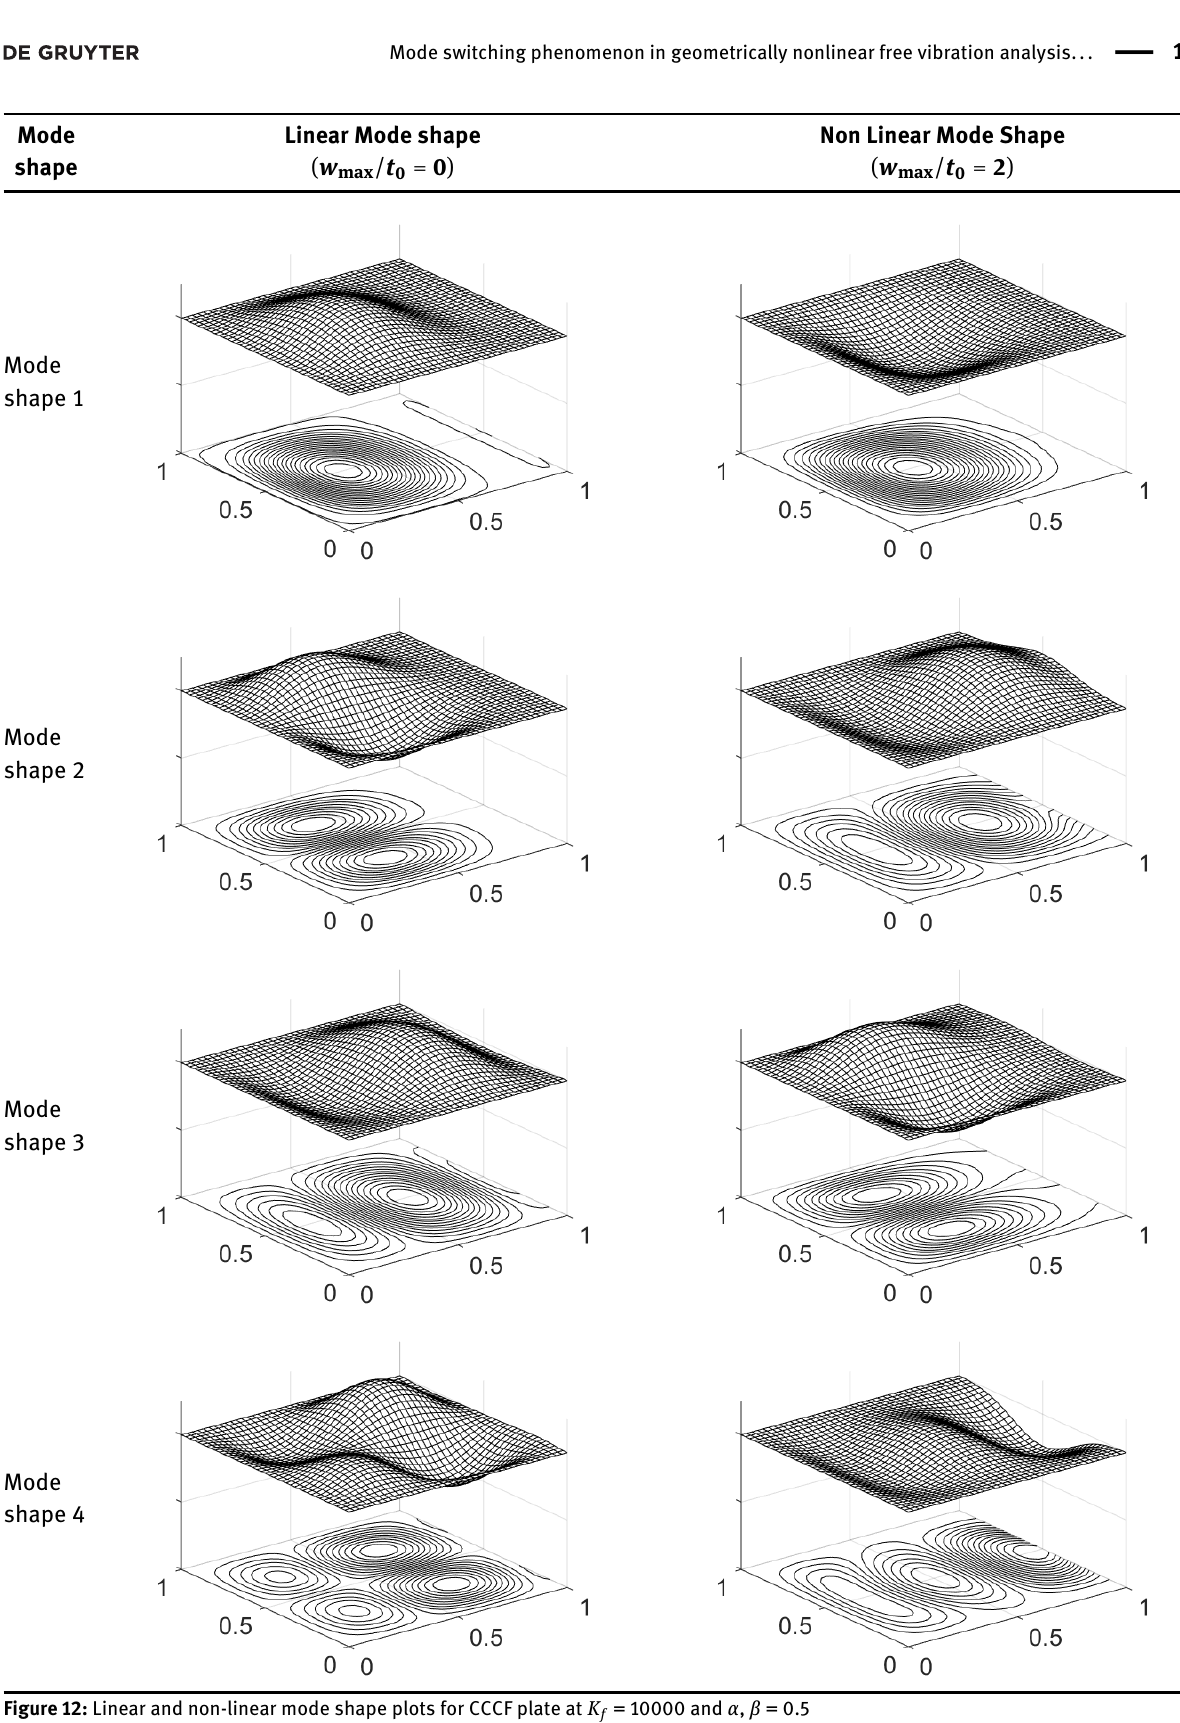
Figure 12: Linear and non-linear mode shape plots for CCCF plate at K f = 10000 and α , β =